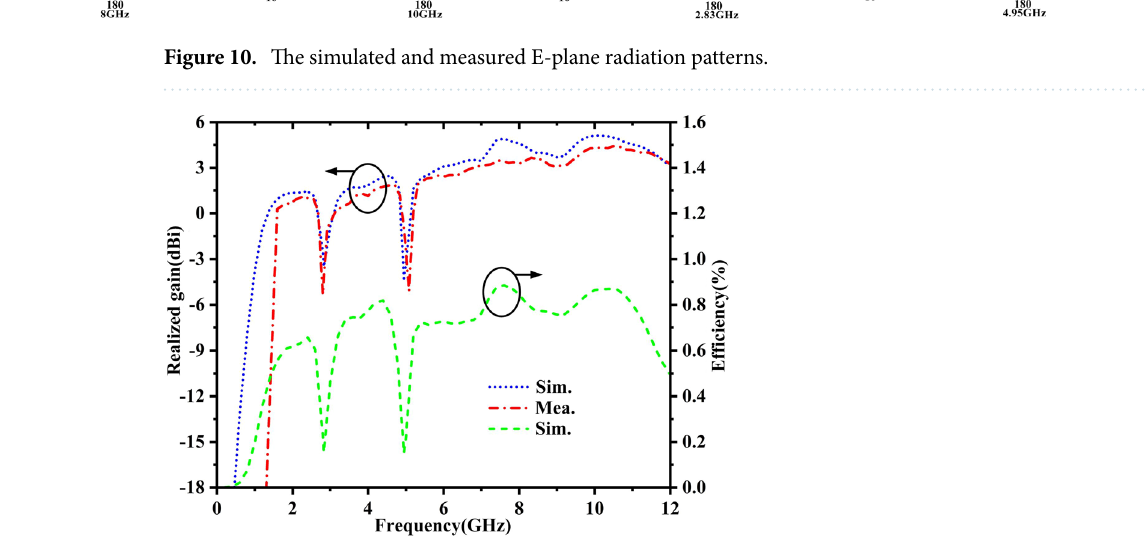
Figure 11. Realized gain comparison and simulated radiation efficiency of the proposed